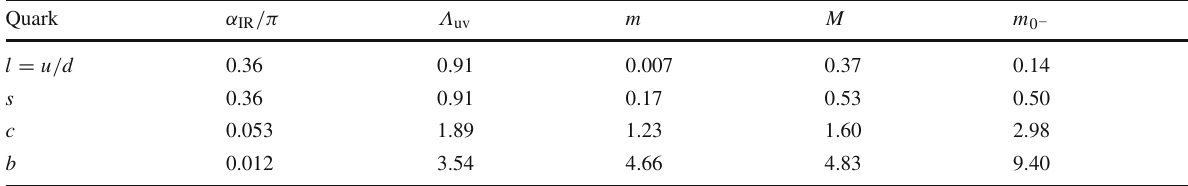
Table 7 Couplings, ultraviolet cutoffs and current-quark masses that deliver a good description of pseudoscalar meson properties, along with the dressed-quark masses and chosen pseudoscalar meson properties theyproduce;allobtainedwith m G = 0 . 5GeV, Λ ir = 0 . 24GeV.Empir-